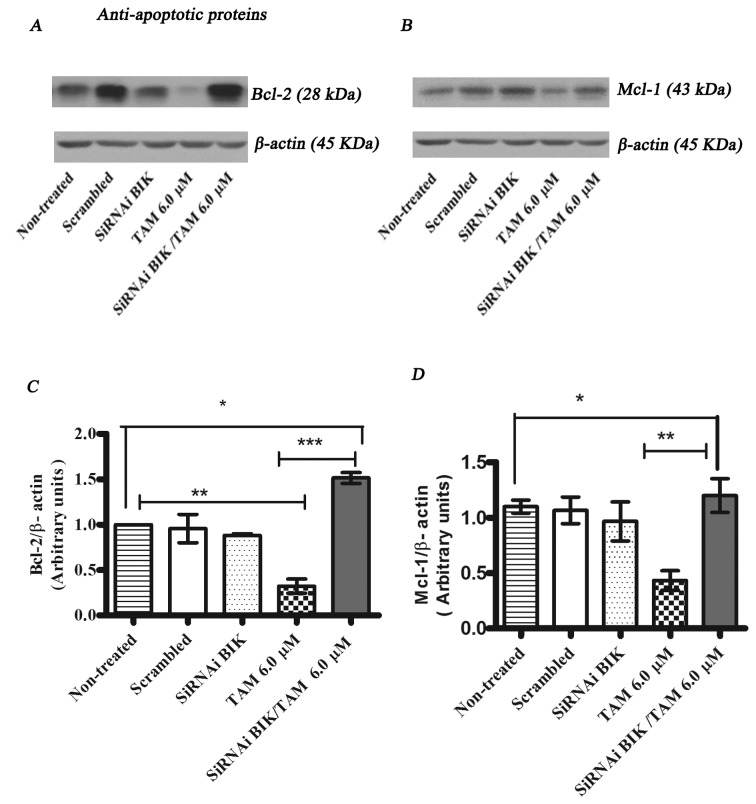
Anti-apoptotic proteins are highly expressed in MCF cells transfected with BIK and treated with TAM. (A and B) MCF-7 cells were incubated for 48 h, cell lysates were prepared from the cells, and subjected to western blot analyses for Bcl-2, and Mcl-1. One representative of at least three independent experiments with similar results is shown. (C and D) Band intensity in Bcl-2, and Mcl-1 was quantified by densitometric analysis. The groups were analyzed by one-way analysis of variance (ANOVA) with the Tukey’s test. *p<0.05; **p<0.01; ***p<0.001 vs. non-treated. Representative figures of three independent experiments carried out in triplicate are shown.